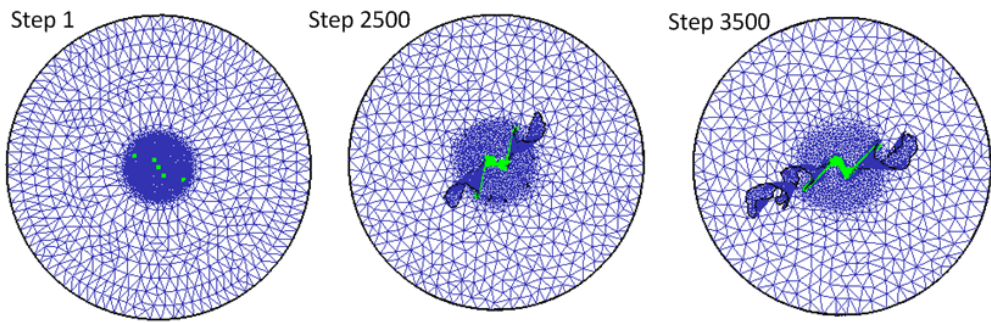
Figure 14. The contact area of the tool and the workpiece.